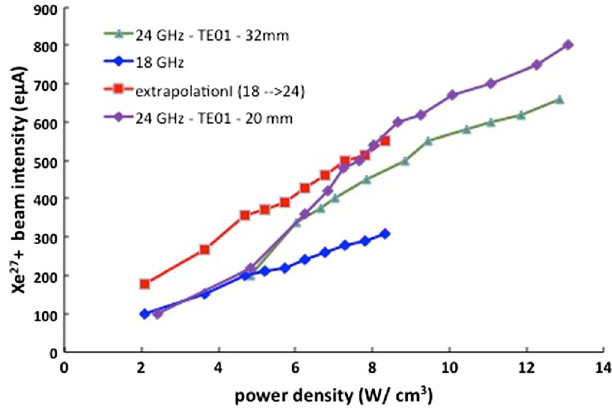
FIG. 19. Dependences of the best beam intensities of 129 Xe 27 þ on the total incident microwave power density at 24 þ 18 GHz and 18 þ 14 . 5